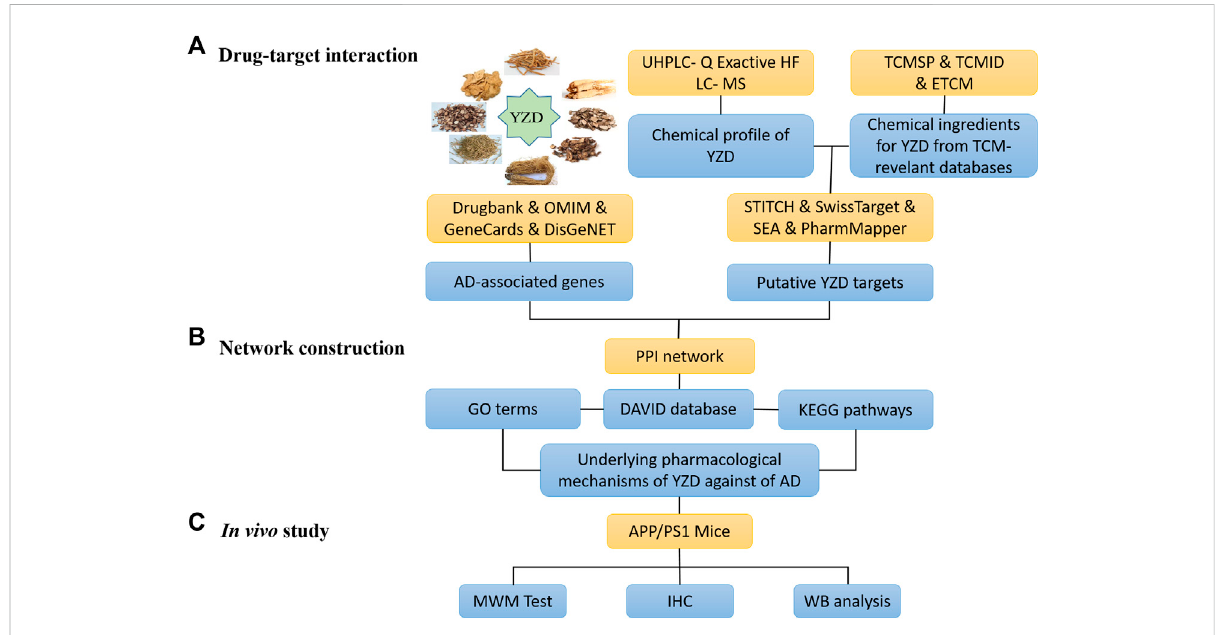
FIGURE 1 FlowchartofthestepstakenduringthesystempharmacologyanalysisofthetherapeuticmechanismsofactionofYuan-ZhiDecoction(YZD)in Alzheimer ’ s disease